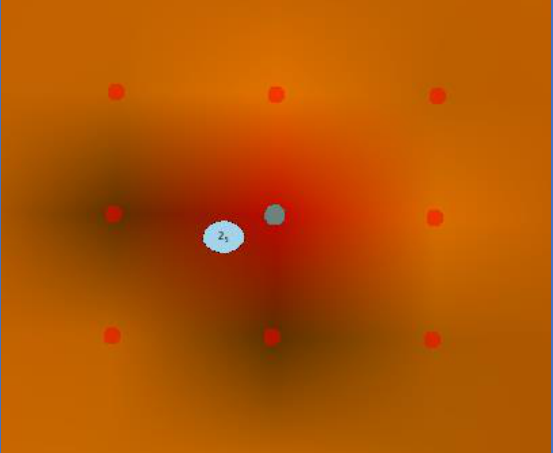
Figure 13. The Check VALSOU algorithm checks the grid node closest in position (cyan dot) to each significant feature and the eight grid nodes surrounding it (orange dots). The minimum depth value of one of these nodes must match the depth reported in the attribution of the significant feature.